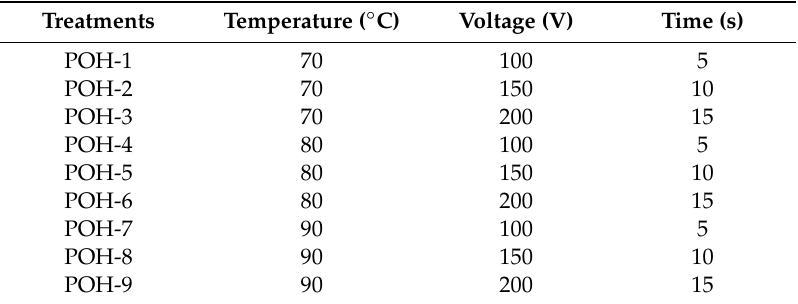
Table 1. Conditions for Ohmic Heating